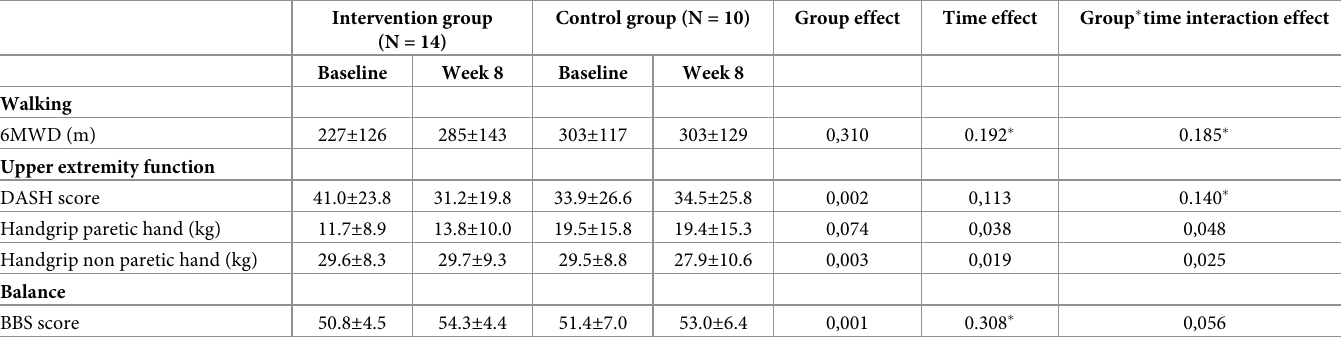
Table 4. Changes in outcome